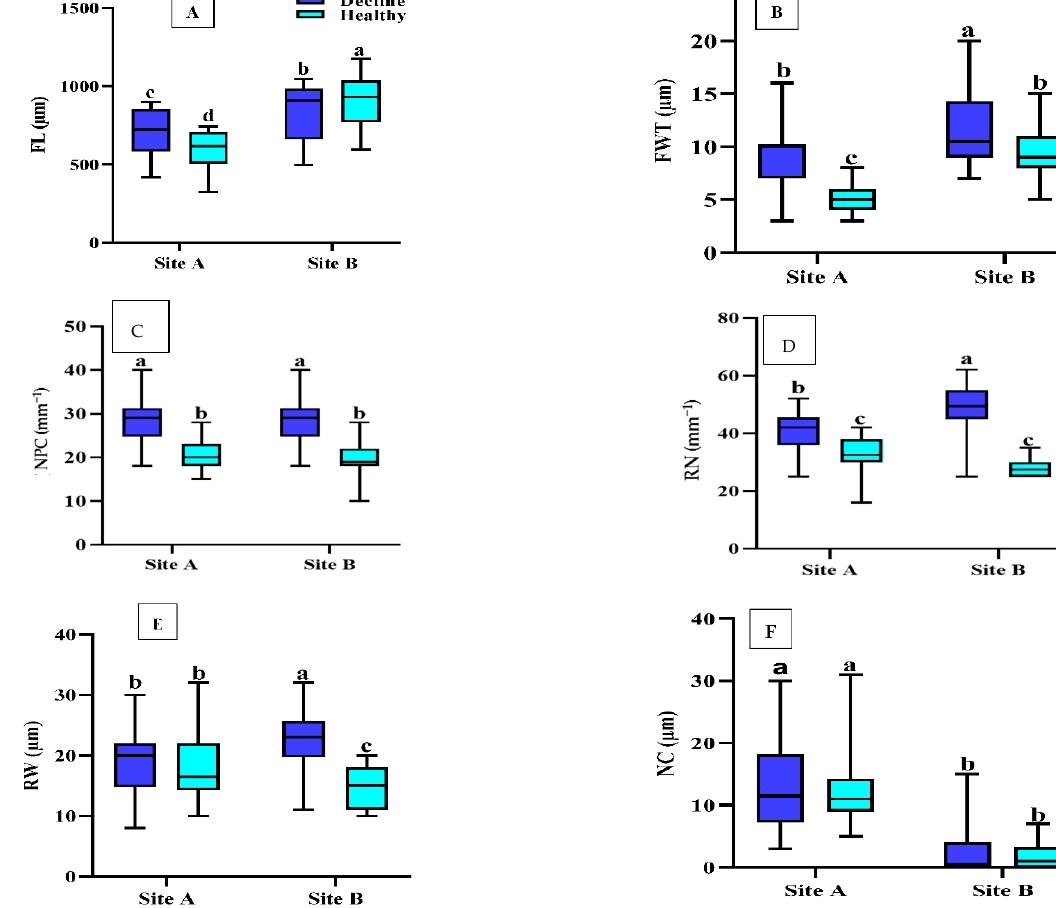
Figure 1. Boxplots of wood anatomy ( A ) FL, fiber length; ( B ) FWT, fiber wall thickness; ( C ) NPC, number of axial parenchymal cells; ( D ) RN, ray number; ( E ) RW, ray width; ( F ) NC, number of crystals) of sapwood from declined and healthy Quercus brantii from two sites in Iran. Site A, Dareh- shahr; site B, Ilam. Vertical bar above each column represents standard deviation. Lowercase letters in the boxes indicate significant differences between declined and healthy trees from the two sites (Duncan’s multiple range test). The same letters indicate no significant differences ( p <